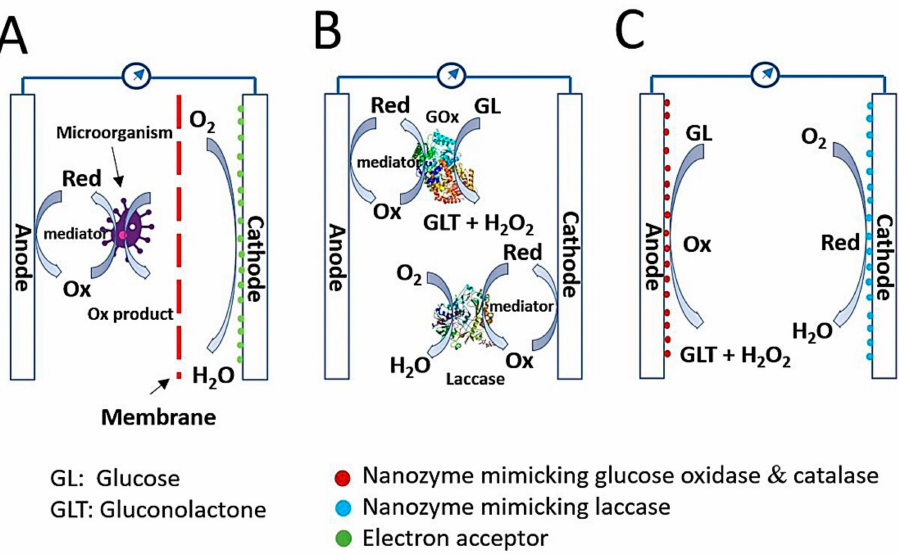
Figure 1. Three representative types of glucose biofuel cells. ( A ) Microbial biofuel cell (MBFC) archi- tecture consists of an anode and cathode constructed using microorganisms, mediator, and supportive electrodes. ( B ) Enzymatic biofuel cell (EBFC) architecture includes an anode and cathode constructed using natural enzymes and mediator. ( C ) Nanozyme-based biofuel cell (NBFC) architecture includes an anode and cathode constructed using